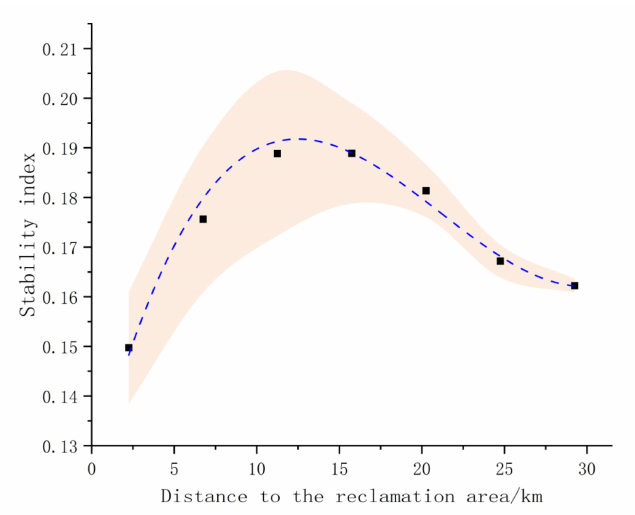
Figure 7. Stability index and deviation of stability in the different buffer